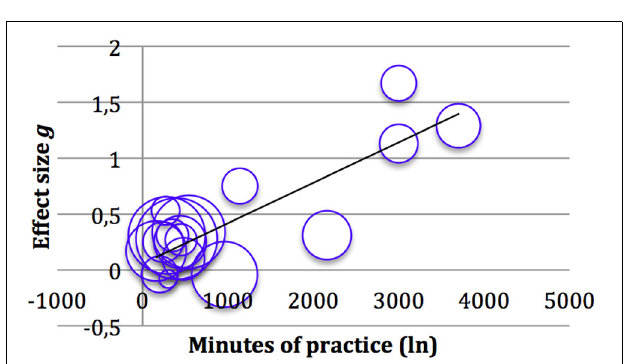
FIGURE 6 | Bubble plot of the 19 controlled effects sizes against Intensity of mindfulness training and regression line. R 2 (adjusted) = 0.52.